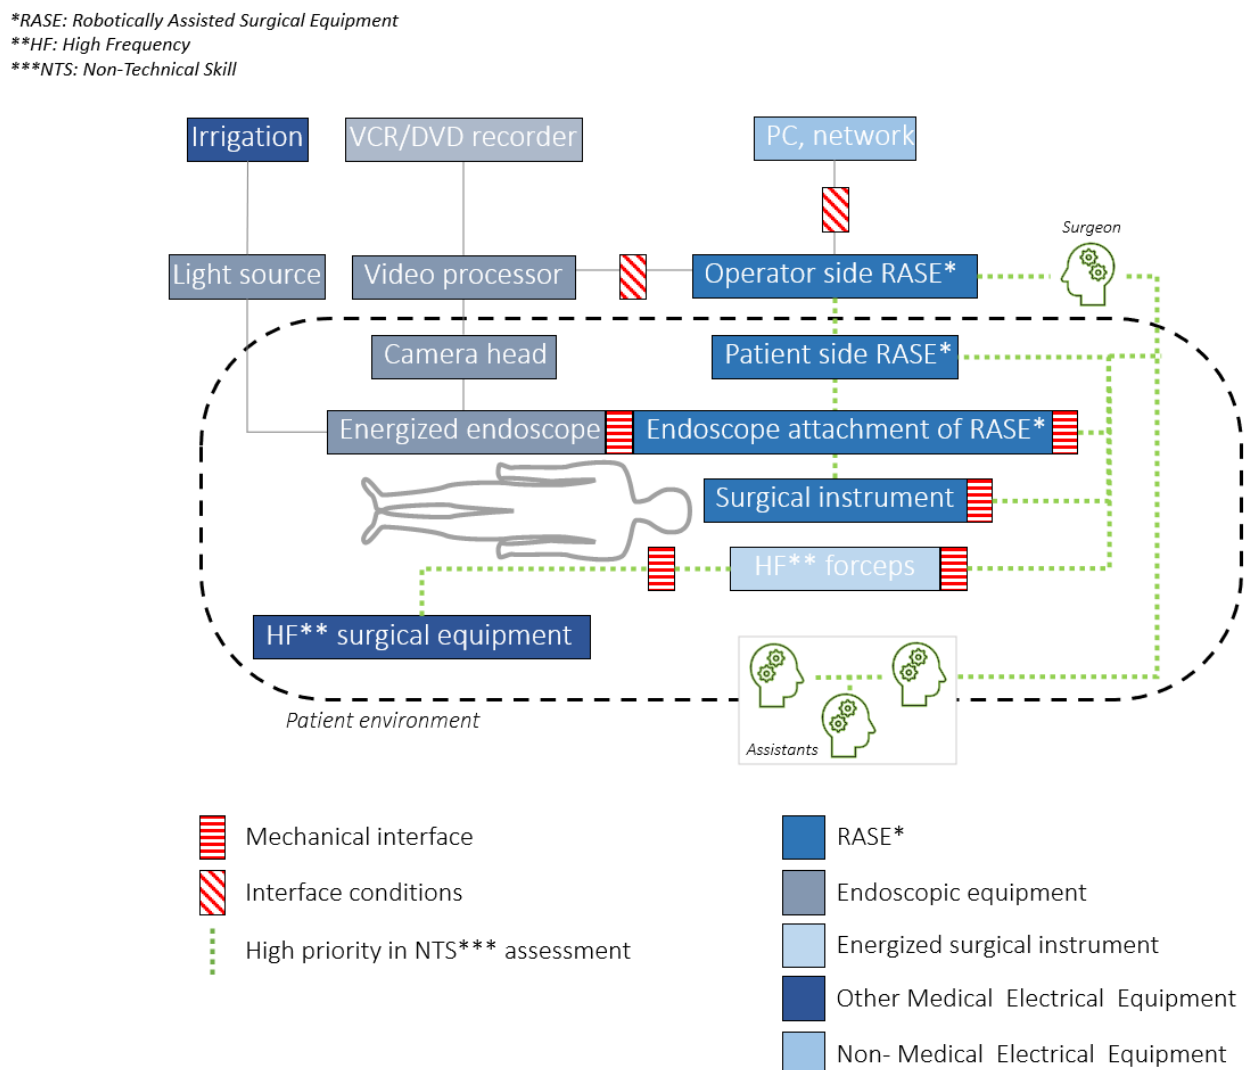
Figure 3. A Robot-Assisted Minimally Invasive Surgical system architecture and typical layout diagram with the most important sensor components in the case of non-technical skill assessment and mental load evaluation based on the International Electrotechnical Commission (IEC) 80601-2-77 robotic surgery safety standard